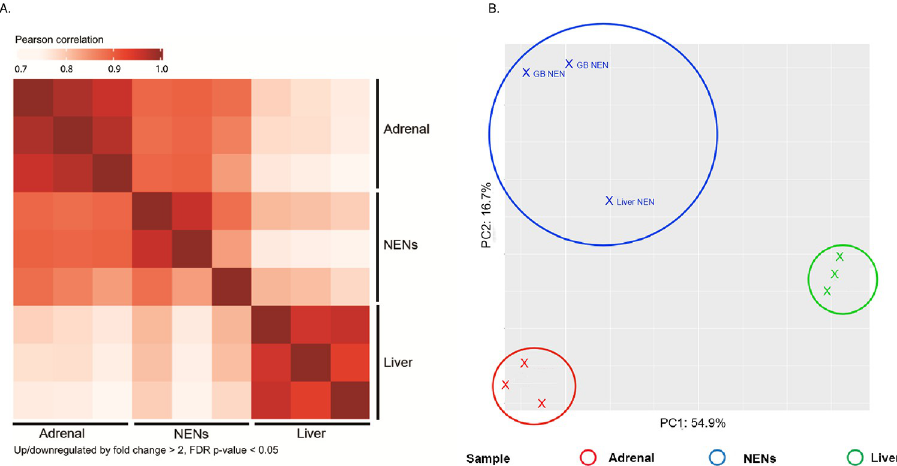
Fig 4. Heat map of protein expression and principal component analysis. Heat map of protein abundance patterns in differentially expressed proteins. Normal adrenal tissue is in the first row and column. Normal liver tissue is in the third row and column. The neuroendocrine neoplasms (NENs) are in the middle row and column. The darker red color indicates protein expression correlation (A). Up/downregulated by fold change > 2 & FDR p-value < 0.05. Principal component analysis (PCA) of normalized gene counts segregated by tissue